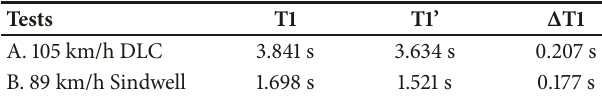
Figure 12: Prediction results for the 89-km/h Sindwell test. Table 2: Prediction of GLTR